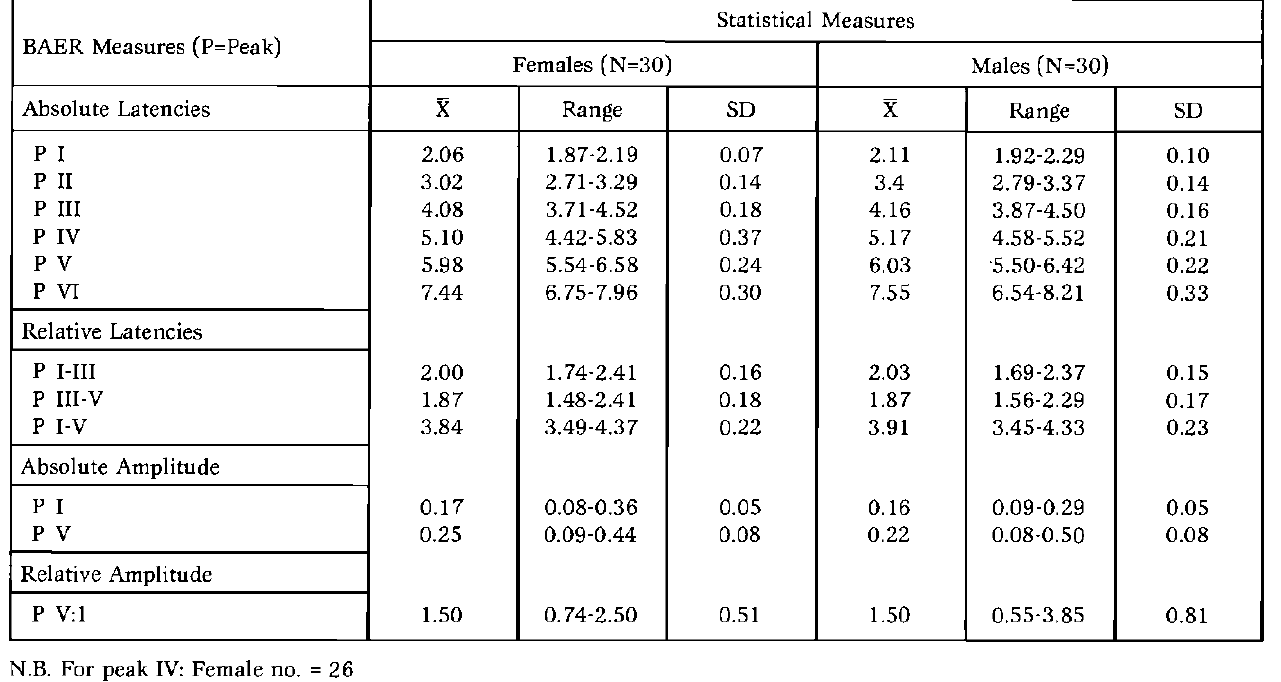
Table 3: Summary statistics for absolute and relative latencies in milli-seconds and absolute and relative amplitude measurements in micro-volts of the monaural evoked BAER in females (N=30) and males (N=30)